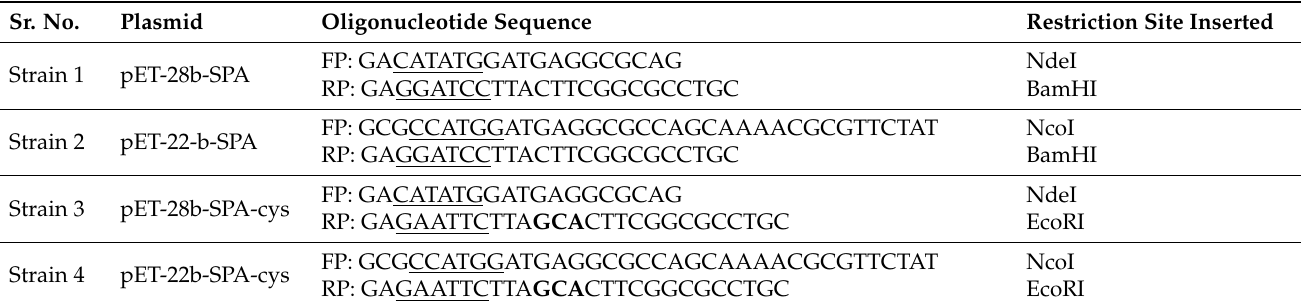
Table 2. Strain details with nucleotide sequence of primers with inserted restriction sites and clones